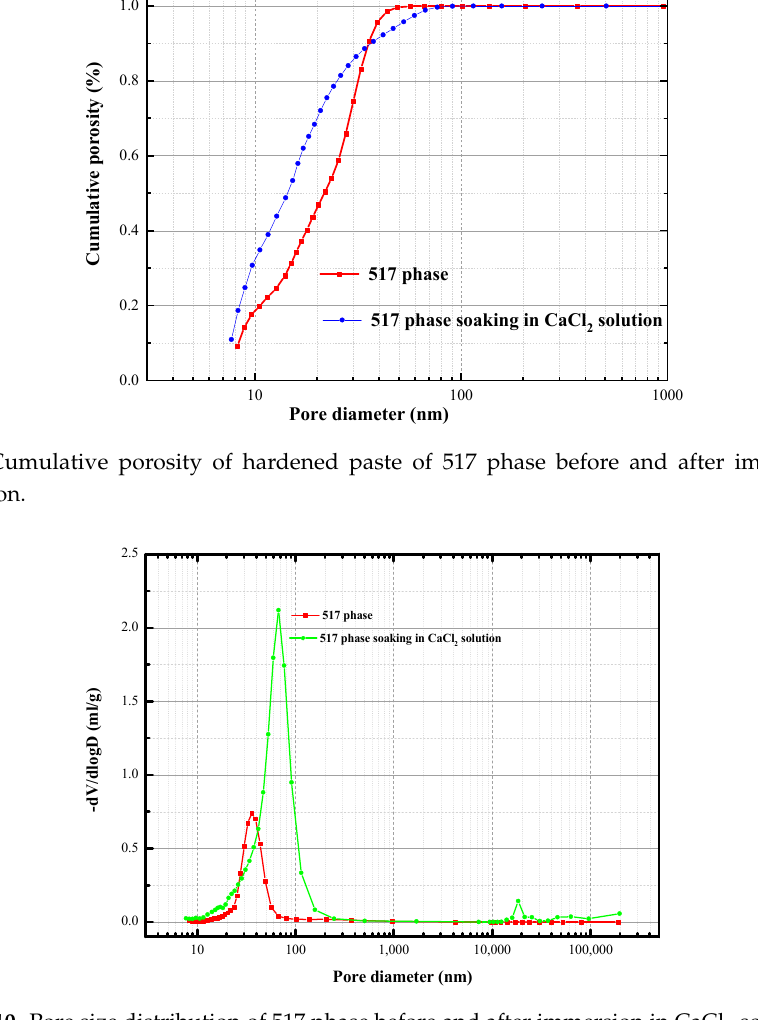
Figure 10. Pore size distribution of 517 phase before and after immersion in CaCl 2 solution.